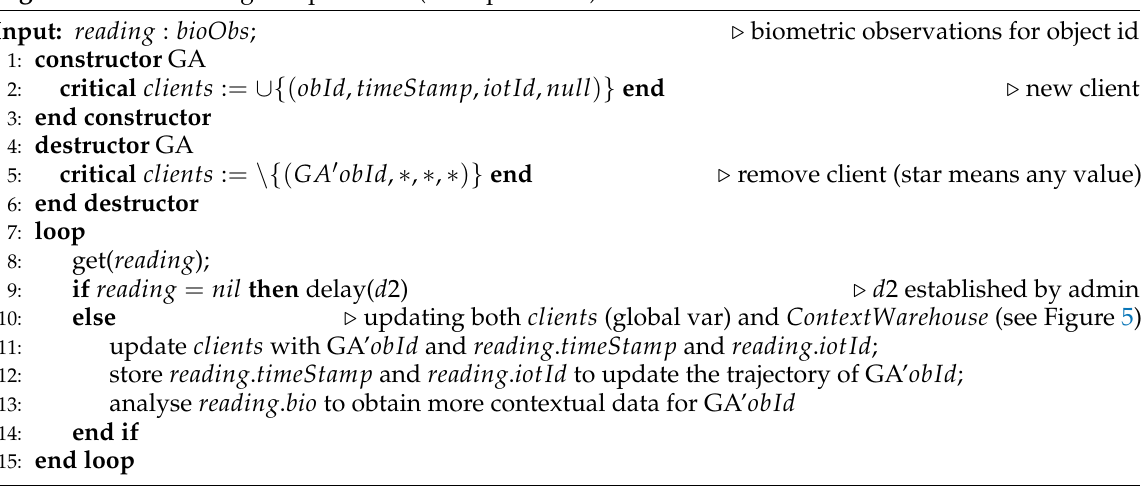
Algorithm 3 The GA agent operations (GA-operations).